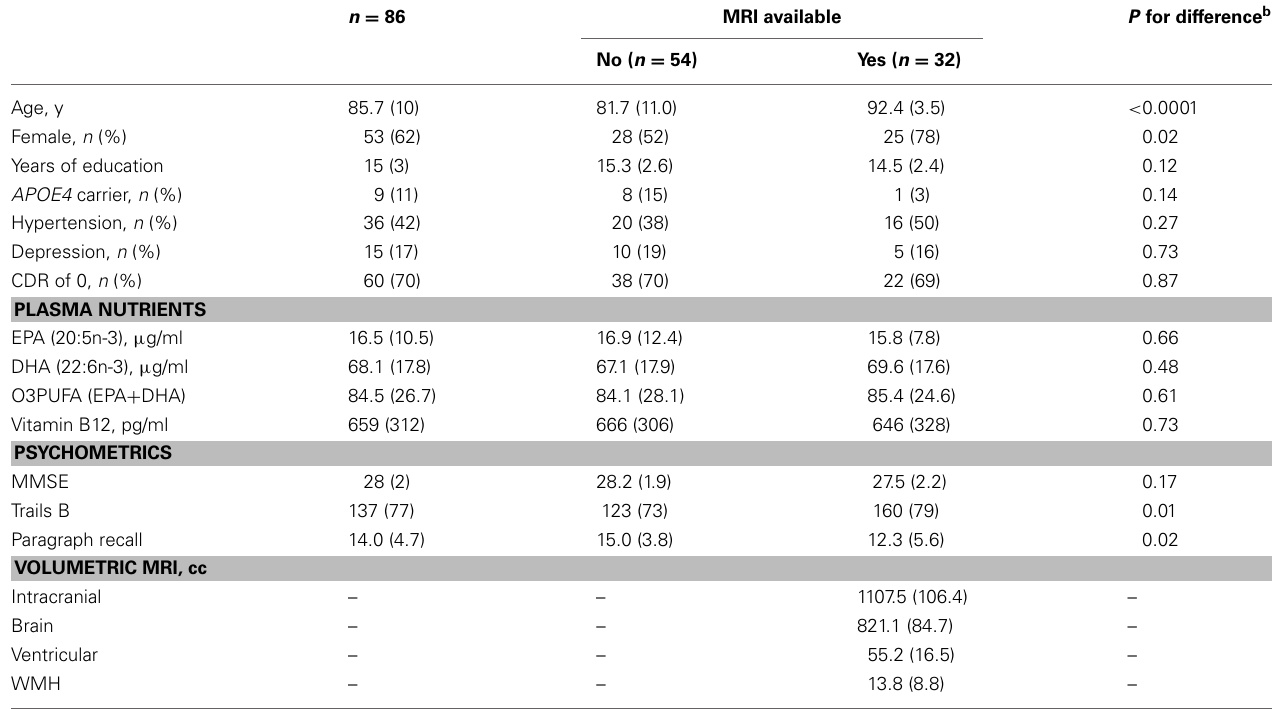
Table 1 | Baseline characteristics of the study popualtion a . n = 86 MRI